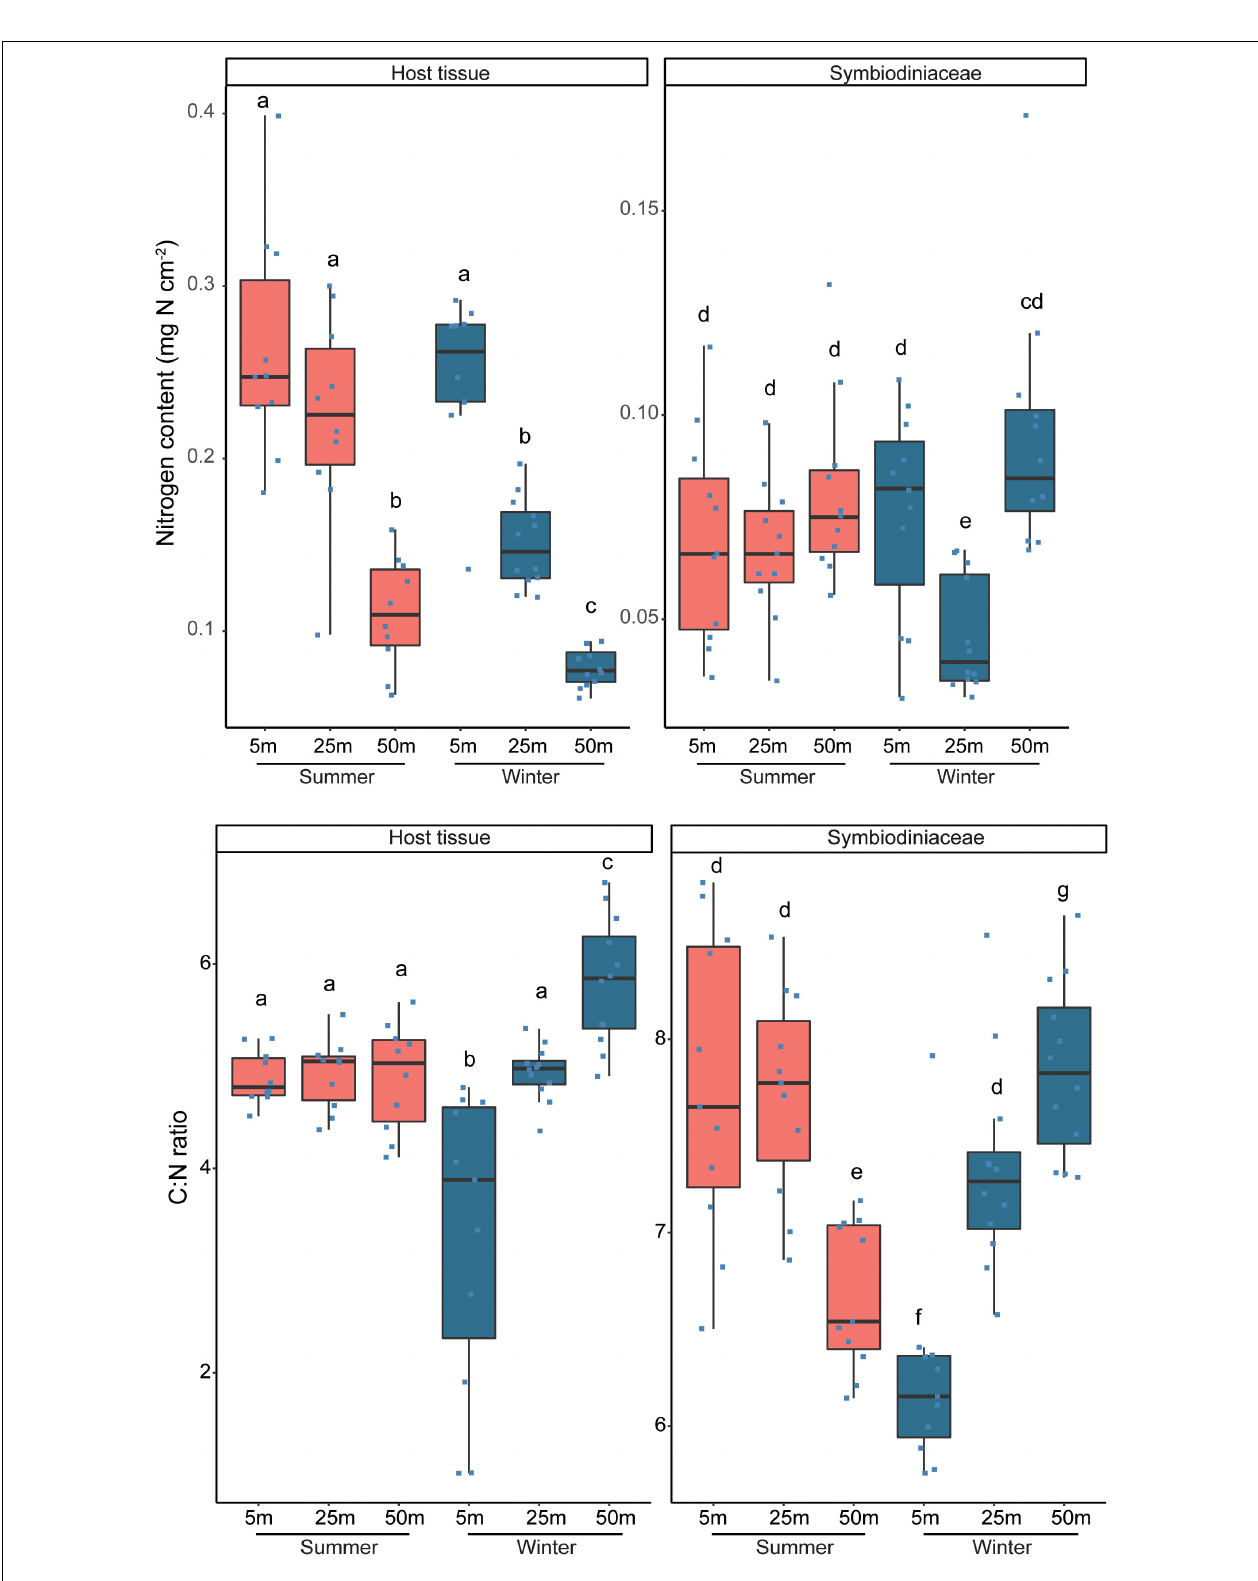
FIGURE 2 | Nitrogen content and atomic C:N ratios of host tissue and Symbiodiniaceae from Stylophora pistillata corals collected along a depth gradient (5, 25, and 50 m) in summer and winter. Different lettering (a–g) above the bars indicates significant differences between samples (Generalized Linear Models; significance level: p < 0.05). Note the different scaling of the y-axes between host tissue and Symbiodiniaceae.